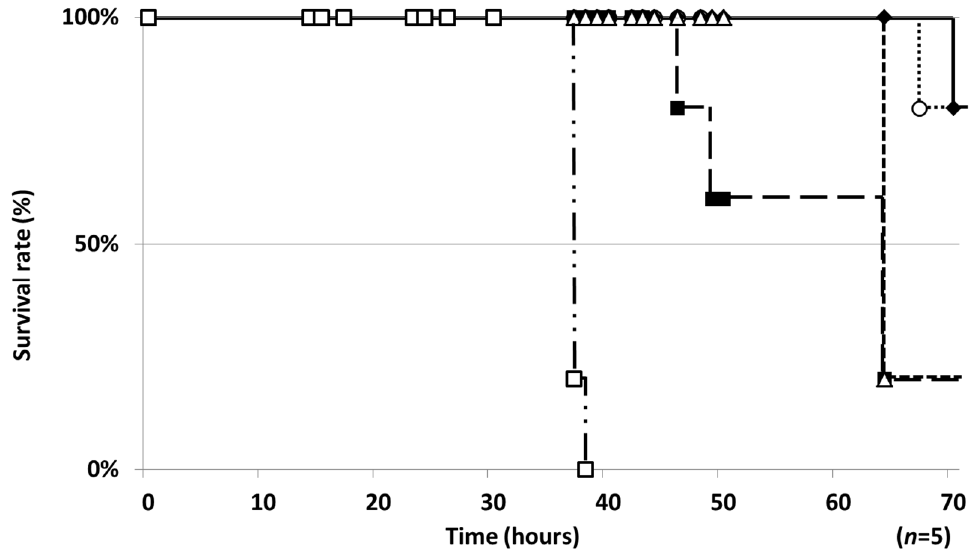
Figure 1. Silkworm-killing ability of four mycobacteria. A suspension of four mycobacteria strains was diluted to the indicated cell number and injected into the silkworm hemolymph. Infected silkworms were incubated at 37 °C. The number of surviving silkworms was counted 70 h after the injection. ◆ : M. avium JCM15430 (6.0 × 10 7 CFU/larva); ■ : M. intracellulare JCM6384 (7.0 × 10 8 CFU/larva); △ : M. avium + M. intracellulare (1.8 × 10 8 + 3.5 × 10 8 CFU/larva); ○ : M. bovis BCG Pasteur (5.0 × 10 8 CFU/larva); □ : My. abscessus ATCC19977 (1.5 × 10 8 CFU/larva). Experiments were performed three times and reproducible data were observed.